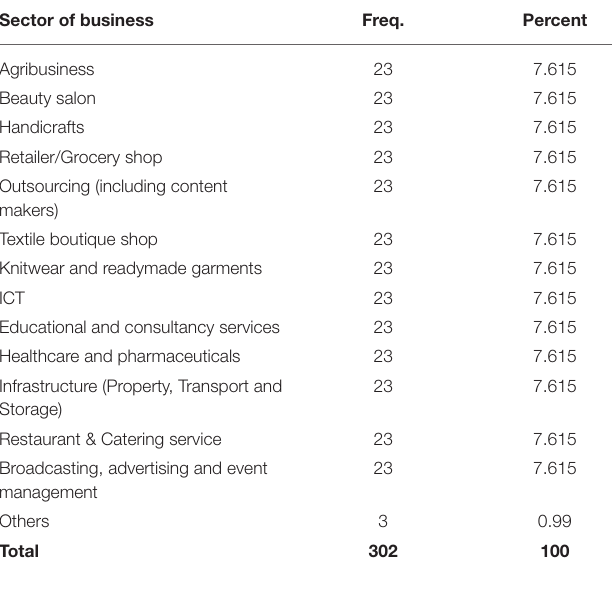
TABLE 1 | Industry/Sector categorisation.